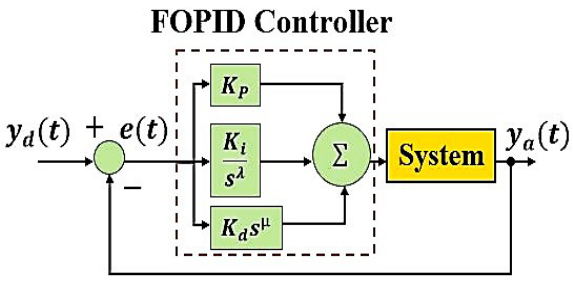
Figure 2. A closed-loop system with the FOPID controller Although the FOPID controller has increased the flexibility, robustness, and stability region of the classical PID controller, the offline tuning process of the five gains in the FOPID controller in (1) using the theoretical-based methods to achieve the high position accuracy is a challenging task. To address this issue, the PSO-SF algorithm is adopted for offline tuning all five gains of the FOPID controller in (2) such that high position accuracy can be achieved. This proposed controller is called the PSO-FOPID controller throughout this